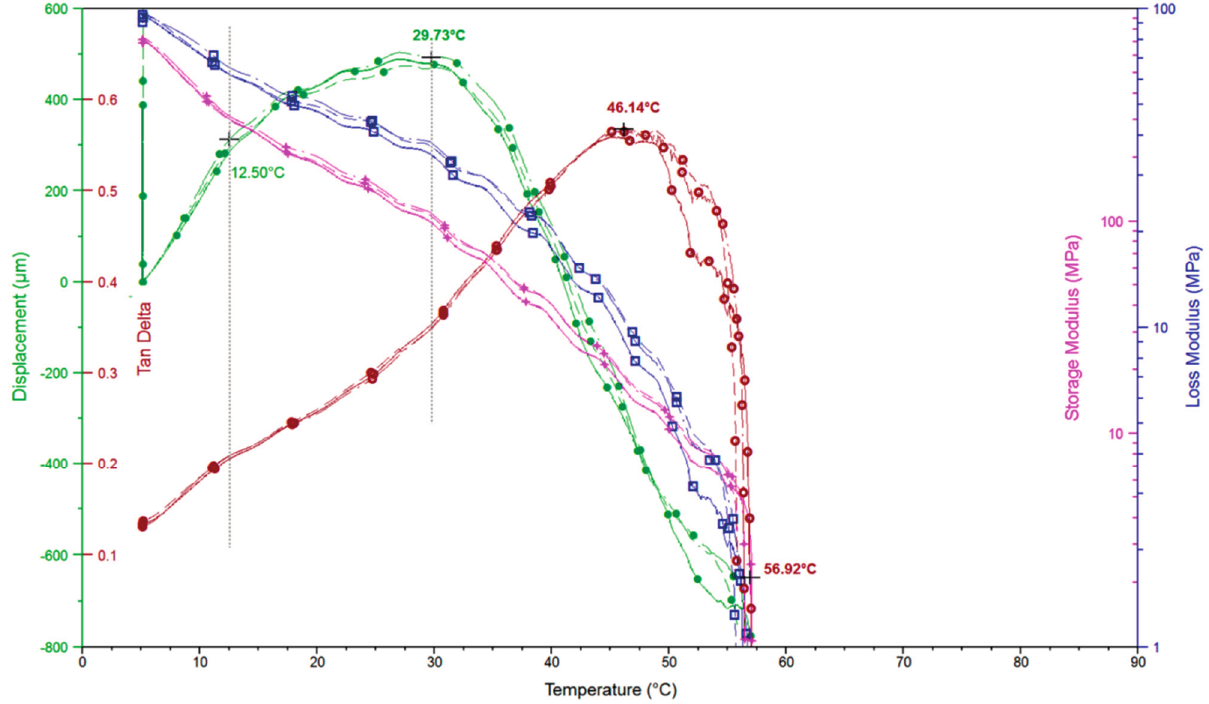
Figure 5. Dynamic temperature ramp, from 5 to 90 °C, at 50% RH: independent triplicate using three strips from the same CaCas/Gly film (~0.04 mm), tested on three consecutive days. Legend: green ( ● ) = clamp displacement ( d ); pink (+) = storage modulus ( E '); dark blue ( □ ) = loss modulus ( E ''); brown ( ○ ) = Tan Delta ( δ